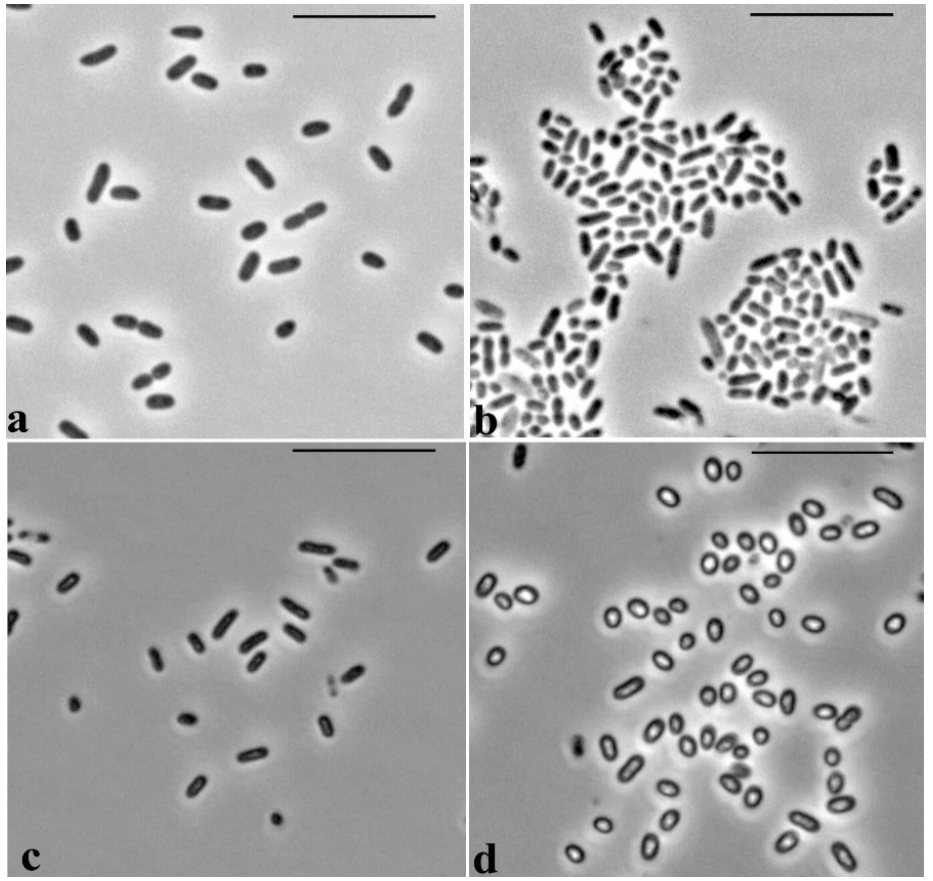
Figure 5. Phase contrast microscopy of P. putida Ch2 cells. ( a , b ) LB medium: ( a ) the 1st day of growth; ( b ) the 4th day of growth. ( c , d ) MS1 mineral medium with glyphosate: ( c ) the 1st day of growth, ( d ) the 4th day of growth. Bar = 10 μ m.